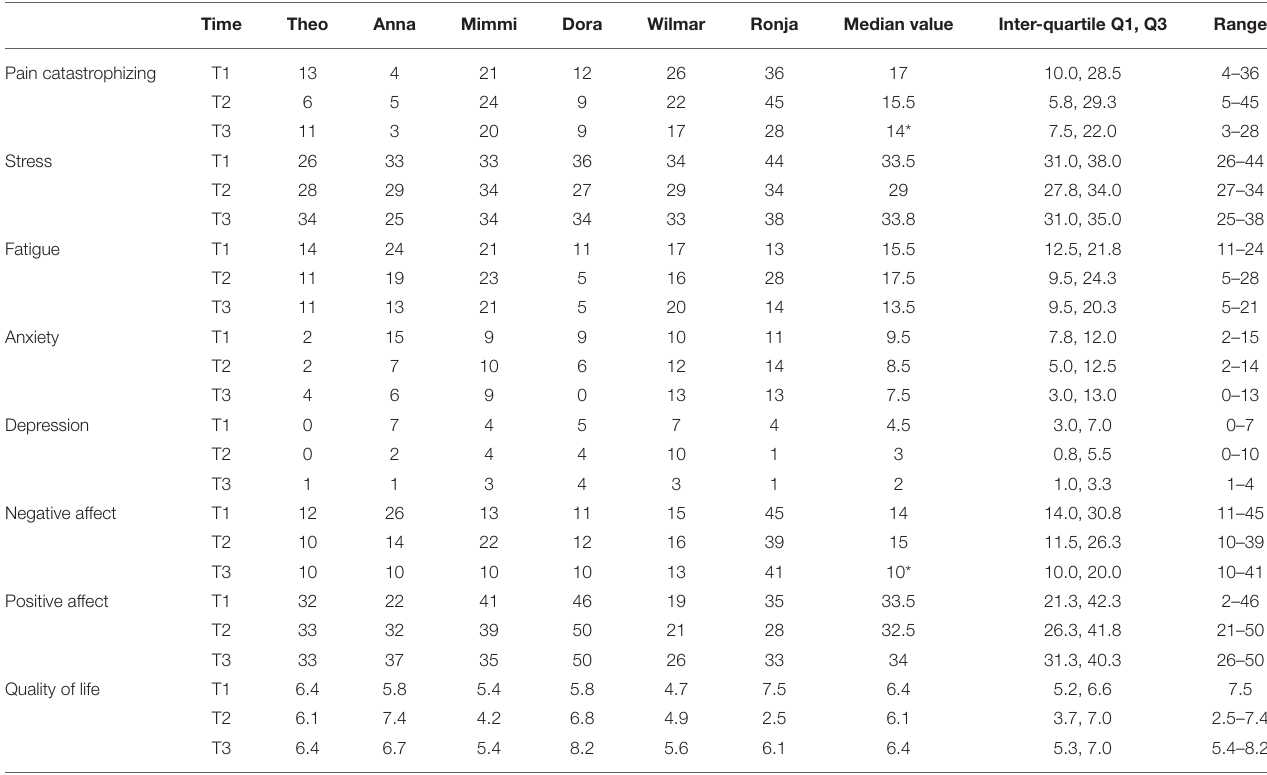
TABLE 3 | Individual and group results on self-report questionnaires at T1, T2, and T3. Time Theo Anna Mimmi Dora Wilmar Ronja Median value Inter-quartile Q1, Q3 Range Pain catastrophizing